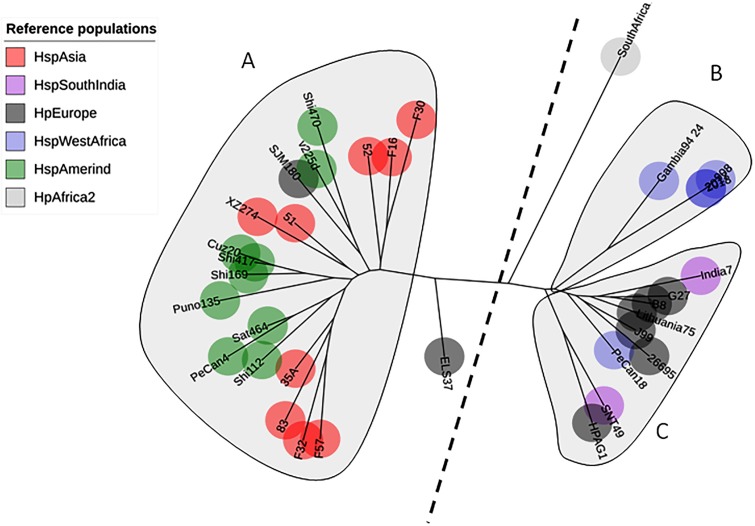
Phylogenetic tree of AlpA from reference strains of H. pylori.The evolutionary history was inferred using the Neighbor-Joining method. The optimal tree with the sum of branch length = 0.84663616 is shown. The percentage of replicate trees in which the associated taxa clustered together in the bootstrap test (1,000 replicates); significant consensus tree branches are showed. The evolutionary distances were computed using the JTT matrix-based method and are in the units of the number of amino acid substitutions per site. The rate variation among sites was modeled with a gamma distribution (shape parameter = 2). The analysis involved 34 amino acid sequences. (A) Clade East. (B) Clade Western. All positions containing gaps and missing data were eliminated. There were a total of 451 positions in the final dataset.